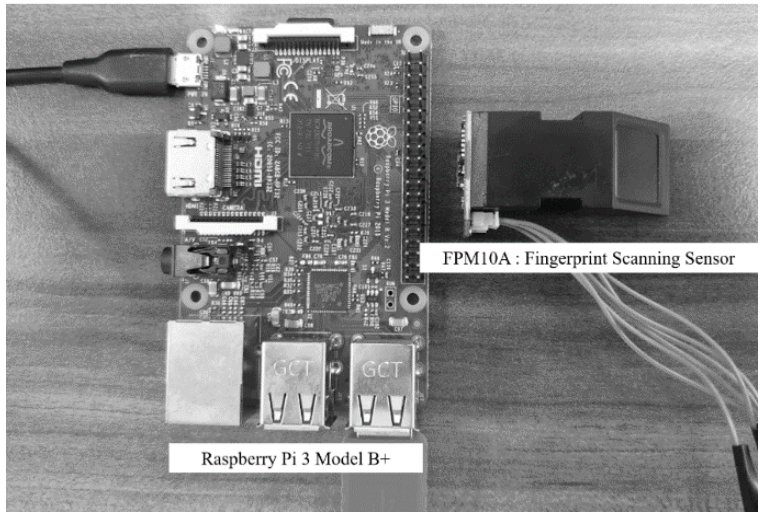
Figure 9. Fingerprint Scanning Sensor.